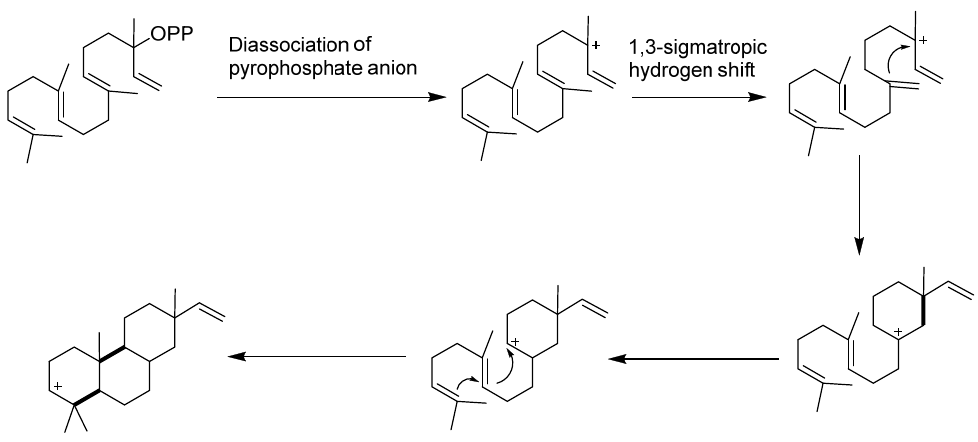
Figure 20. Previous biosynthesis of pimarane diterpene skeletons.